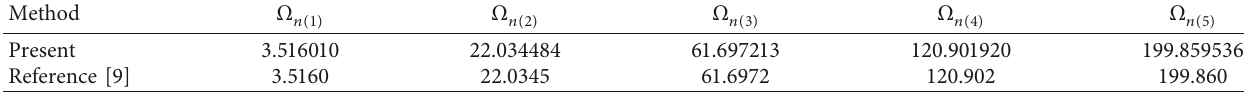
, i � 1 , . .. , 5 ) for the small vibration amplitude. n ( i )